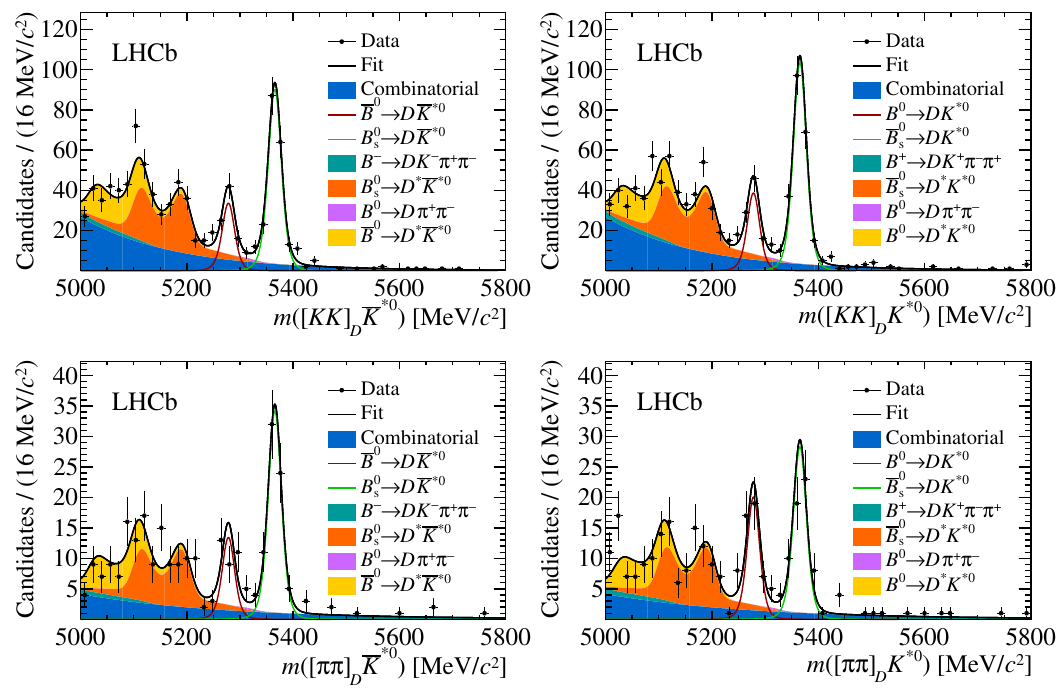
Figure 2 . Invariant-mass distributions (data points with error bars) and results of the (cid:12)t (lines and coloured areas) for the two-body GLW modes (top left) B 0 ! D ( K + K (cid:0) ) K (cid:3) 0 , (top right) B 0 ! D ( K + K (cid:0) ) K (cid:3) 0 , (bottom left) B 0 ! D ( (cid:25) + (cid:25) (cid:0) ) K (cid:3) 0 and (bottom right) B 0 ! D ( (cid:25) + (cid:25) (cid:0) ) K (cid:3) 0